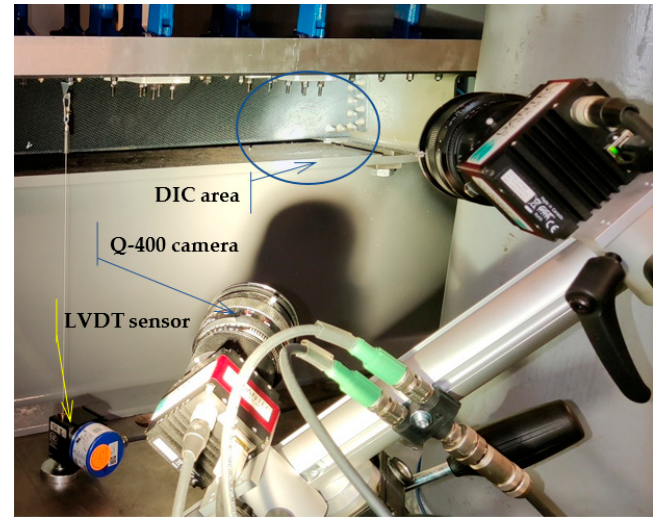
Figure 10. Arrangement of Q-400 measurement system and LVDT sensor no. 2.